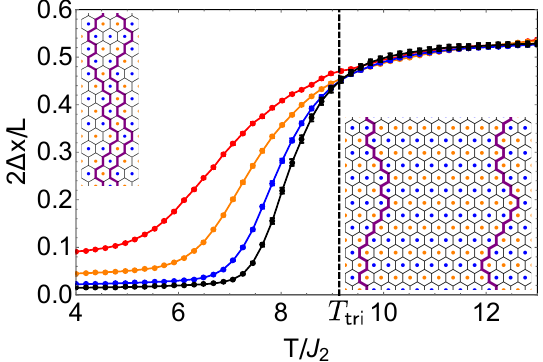
Figure 30: The average separation of a pair of strings, 2 ∆ x / L [ Eq. 89 ] . Monte Carlo simulations are carried out in a reduced manifold of Ising configurations, constrained to have exactly two strings. The simulations use a square cluster with linear sizes L = 24 (red), L = 48 (orange), L = 96 (blue) and L = 144 (black). At low temperature the strings bind together (see left-hand inset), while at higher temperatures the strings repel one another (see right-hand inset). The dashed line shows the temperature of the Pokrovsky-Talapov tricritical point, T tri , as measured by Monte Carlo simulation (see Fig.